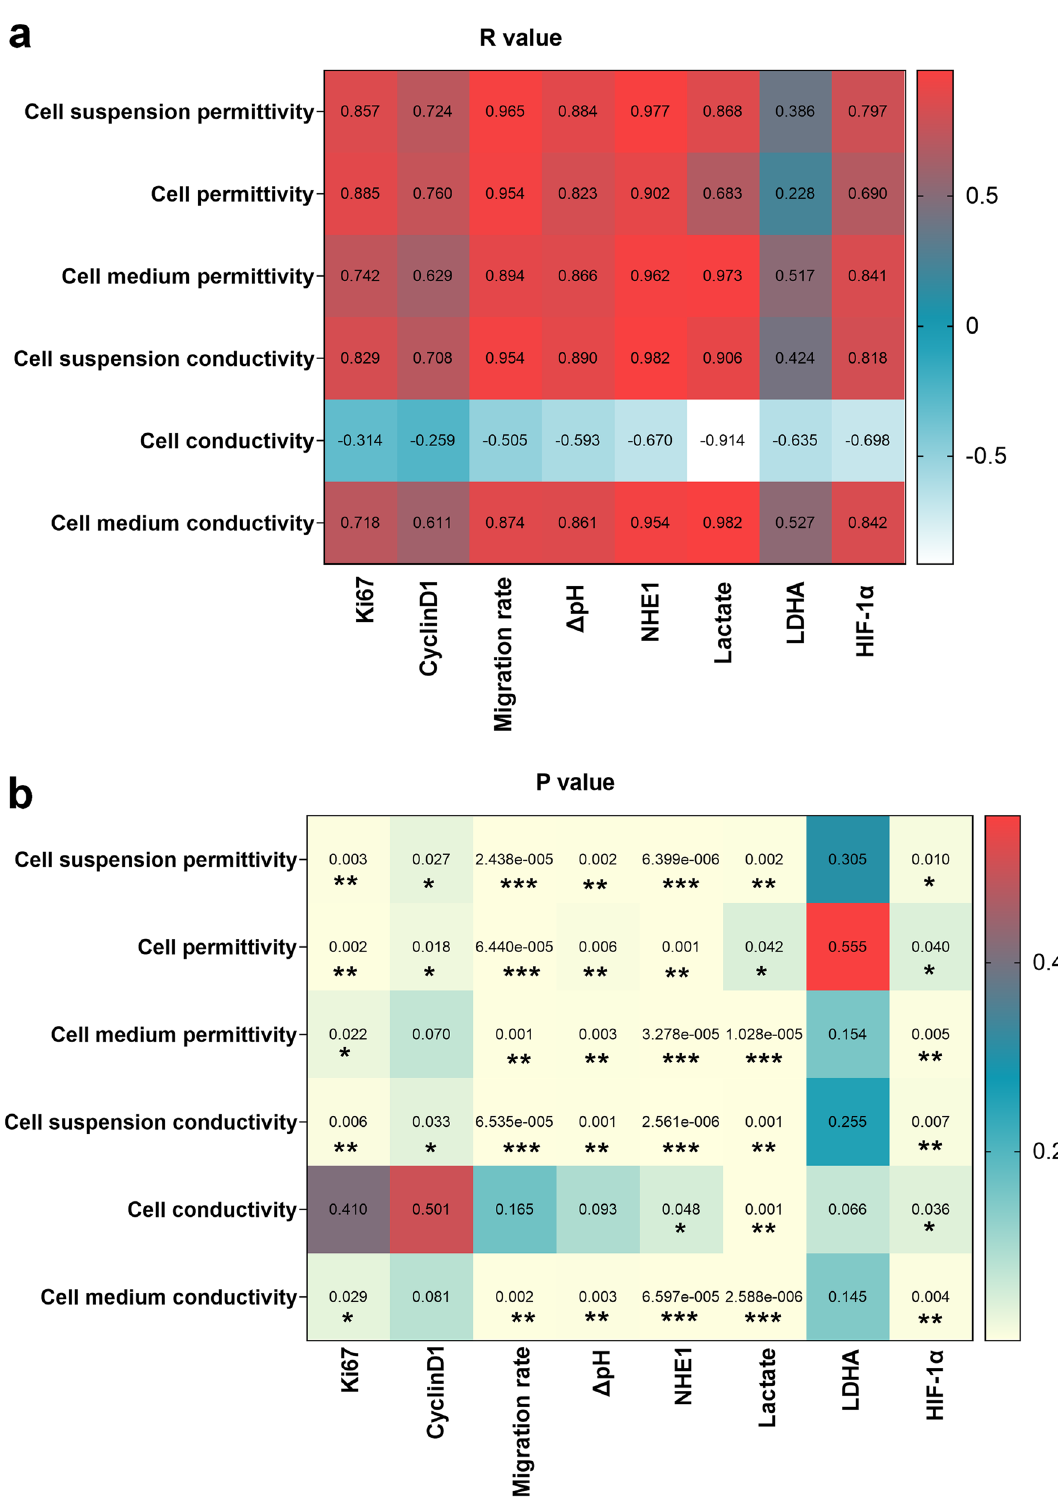
Figure 5. R and p values between the electrical characteristics of breast cells and biomarkers at 1 MHz. ( a ) Heatmap of r values. ( b ) Heatmap of p